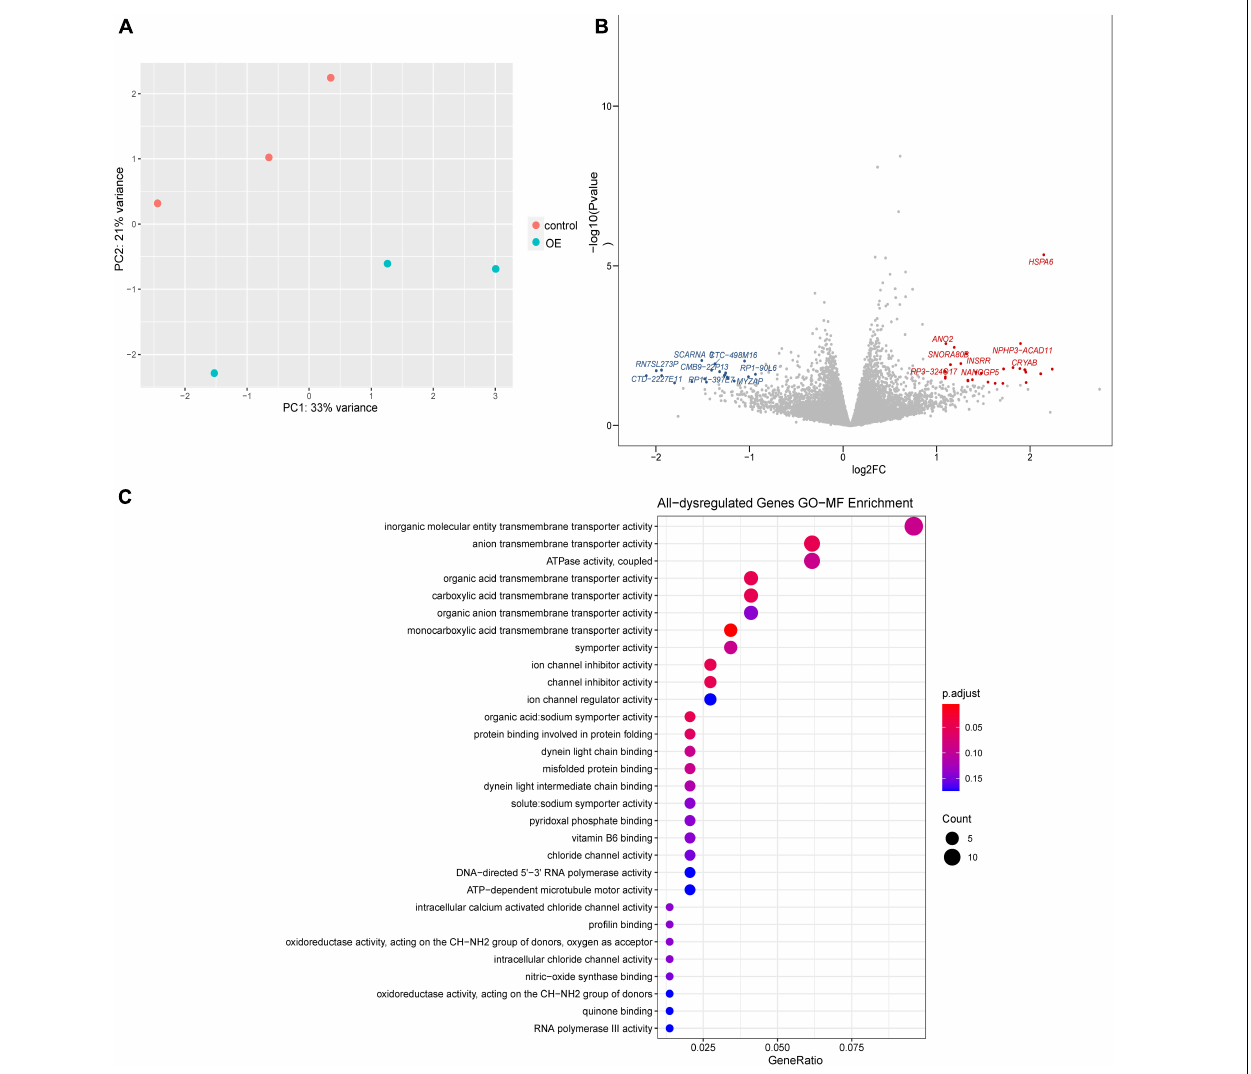
FIGURE 3 | Differential gene expression analysis of lnc-TSSK2-8 overexpression in HEK293 cells. (A) Principal component analysis of RNAseq data derived from lnc-TSSK2-8 overexpression and control cell samples. (B) Volcano plot of differential gene expression analysis; symbols of the top 15 for each of upregulated and downregulated genes were labeled. (C) Gene Ontology (GO) gene set functional enrichment analysis of